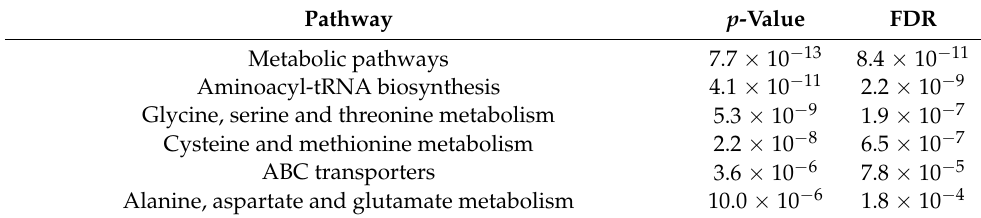
Table 5. Pathway enrichment analysis of differential metabolites in ESI+